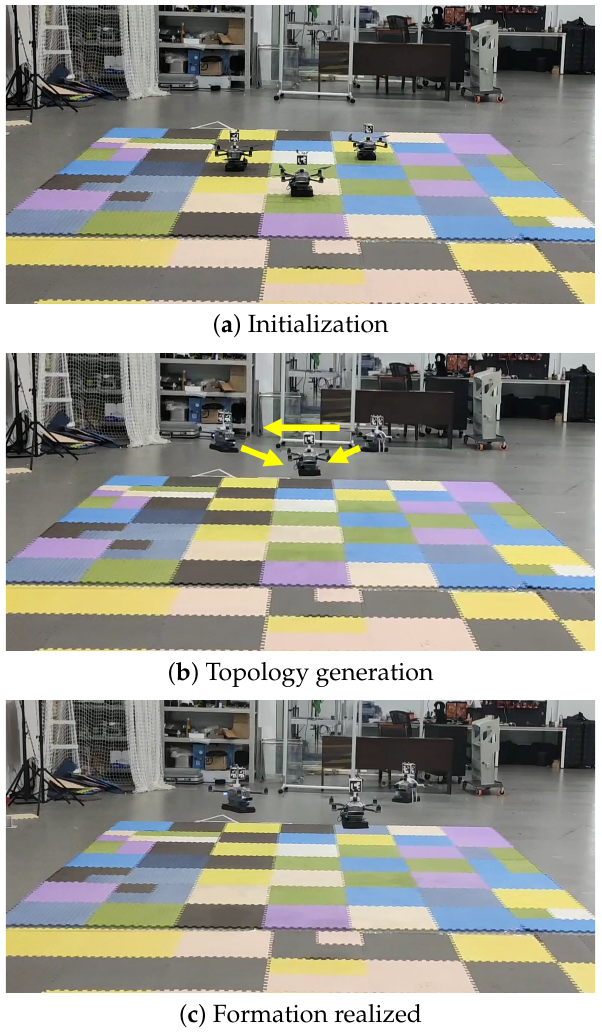
Figure 16. Experimental results. ( a ) Initialization of formation configuration. ( b ) Generation of minimally persistent graph. ( c ) Realization of the desired